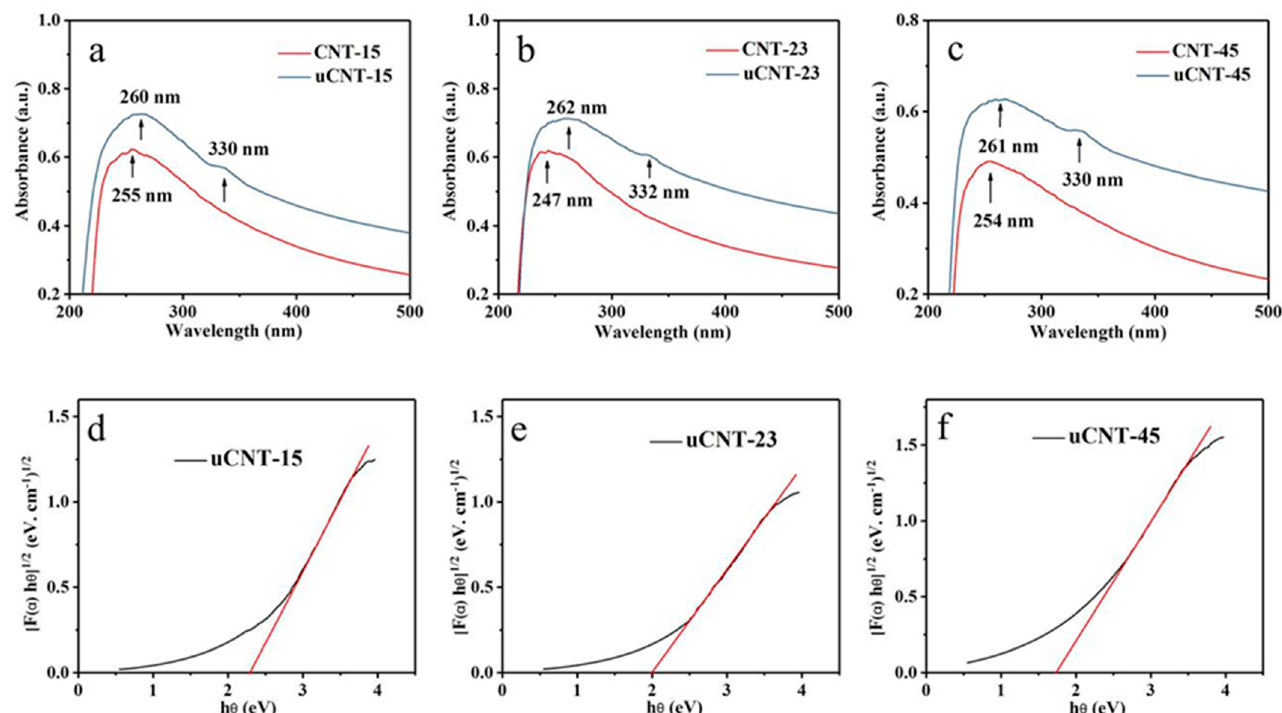
Figure 7. UV-Vis spectra of CNTs and uCNTs ( a – c ); band gap of uCNTs ( d – f ).